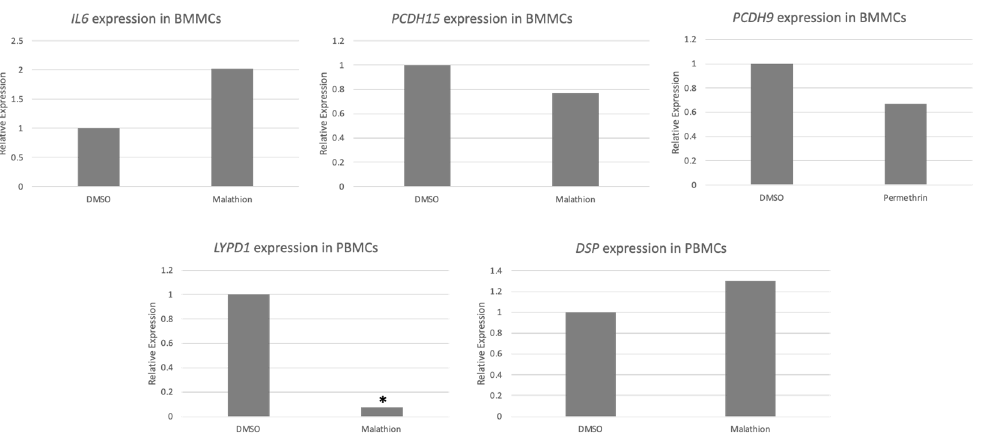
Figure 12. qPCR validation of changes in gene expression in cells exposed to insecticides. Gene expression alterations were assessed on independent PBMCs and BMMCs exposed to malathion and permethrin (0.1 μ M, 72 h) * p < 0.05, t test.